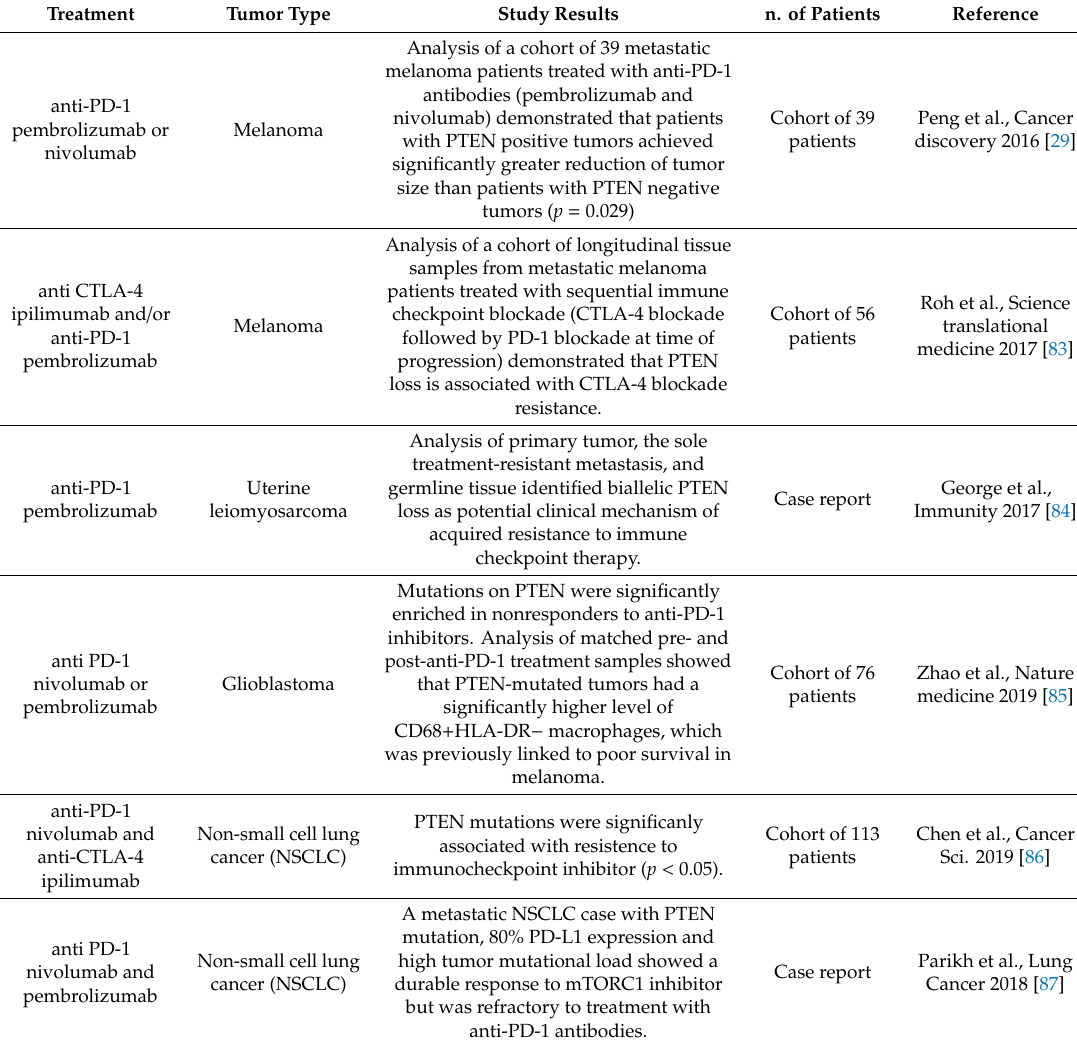
Table 2. PTEN pathway and immunotherapy response in